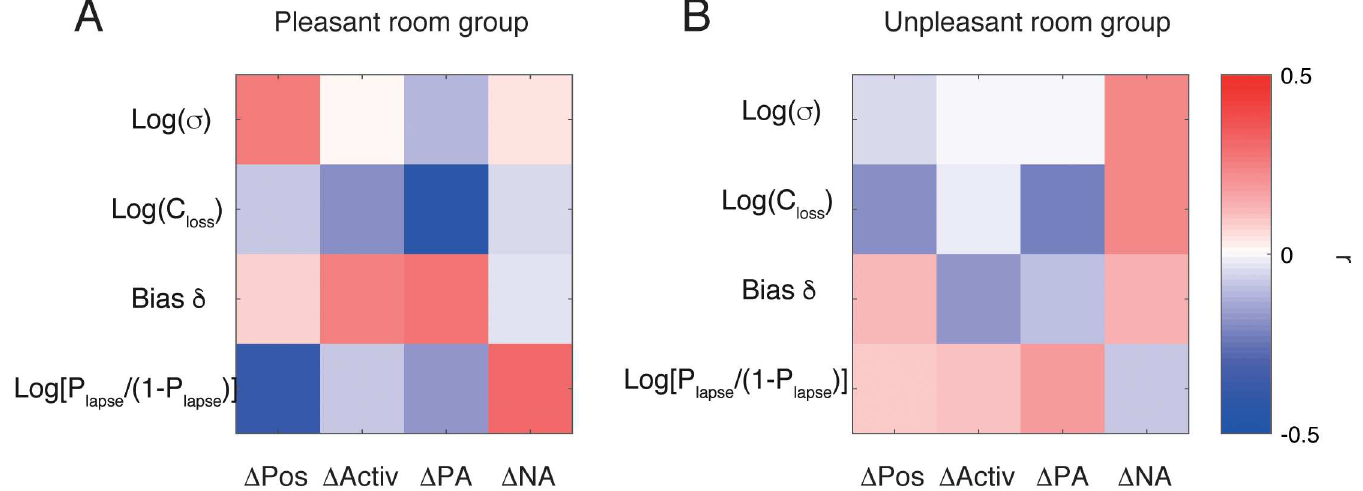
Fig 8. Correlations between estimated parameters and the changes in questionnaire scores (affective measures). A The Pleasant room participants. B . The Unpleasant room participants. The colour shows the correlationcoefficient r , where blue means negative ( r < 0) and red means positive ( r > 0). The changes in score were computedas the score after Session 3 minus the score before Session 1. None of the correlationswas significant after the multiple comparison correction.